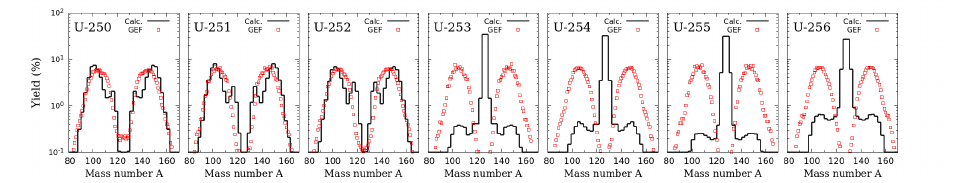
Figure 2. The calculation results of fission fragment mass distributions (FFMDs) for 250 U to 256 U with the excitation energy of E ∗ = 7 MeV compared with the data from GEF code [17].